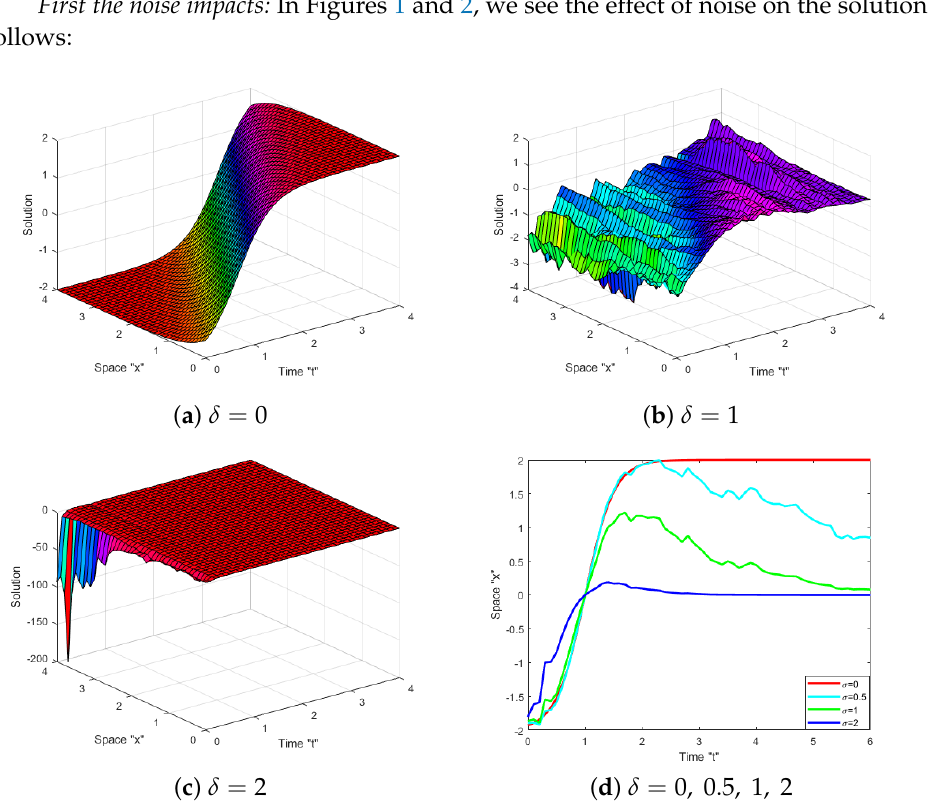
Figure 1. ( a – c ) Three-dimensional graph of solution W ( x , y , z , t ) in Equation (21) for various δ = 0, 1, 2; ( d ) two-dimensional graph for various δ = 0, 1,